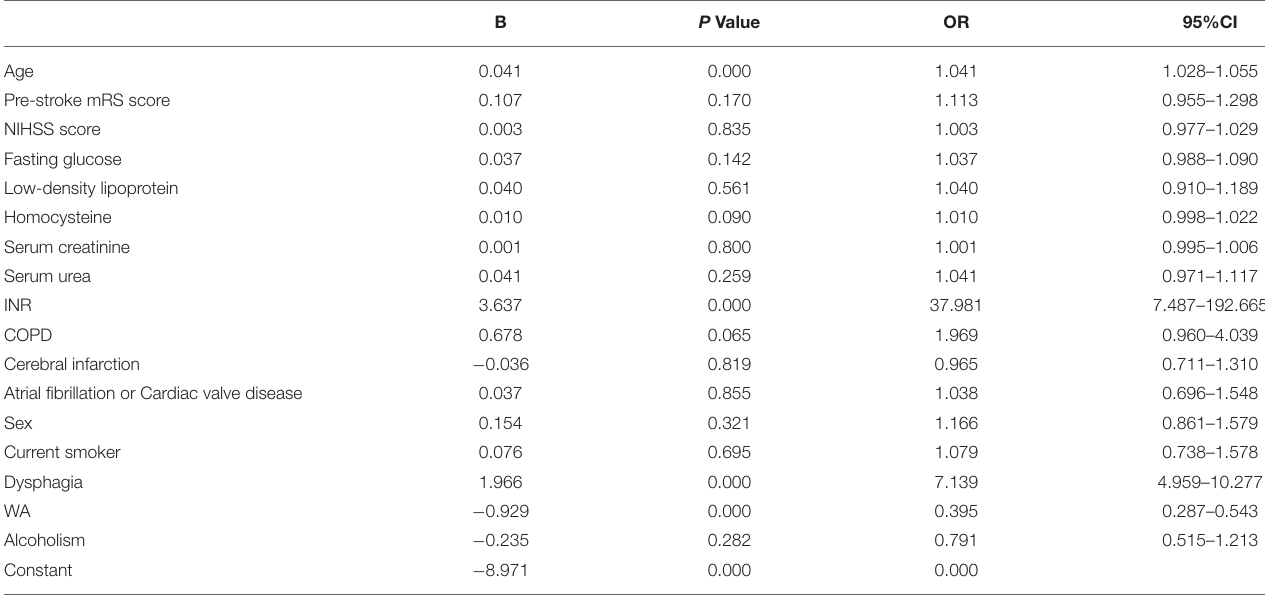
TABLE 2 | Multivariate analysis of factors influencing SAP.